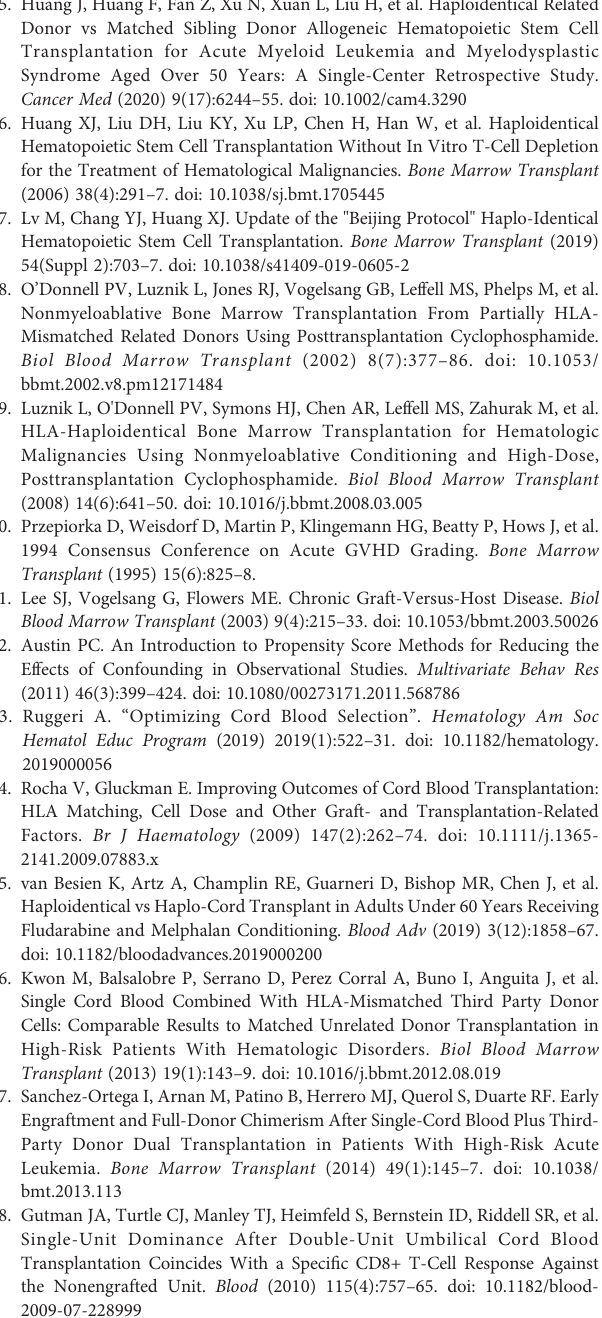
Supplementary Figure S3 | Standardized mean differences in weighted and unweighted